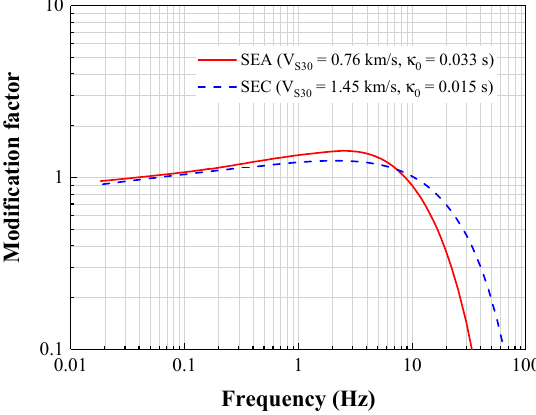
Figure 2. Shear-wave velocity profile: ( a ) SEA; ( b ) SEC, in which CRUST1.0 is a global crustal database (https: // igppweb.ucsd.edu / ~gabi / crust1.html, last accessed in January 2019), the shear wave velocity data can be found in the “Supplementary Materials”.